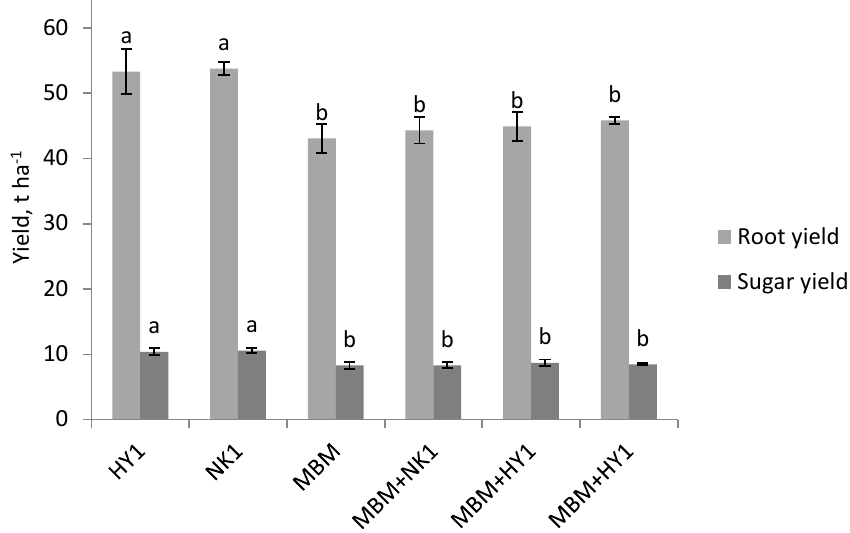
Fig. 2. Root yield and sugar yield in sugar beet by different fertilizations in 2009. (Error bars: ± standard error. Different lowercase letters above columns indicate significant ( p =0,05) differences between the